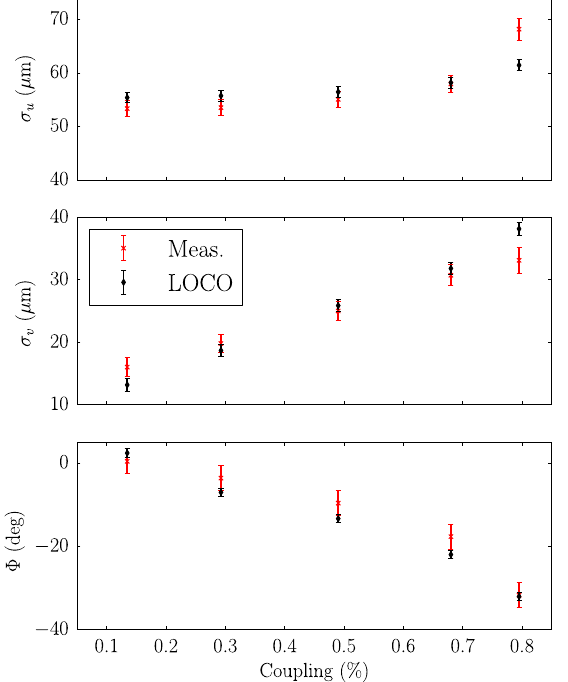
FIG. 13. Comparison of the SRI reconstruction with the results from LOCO for the horizontal and vertical beam size and the beam tilt at the Xanadu